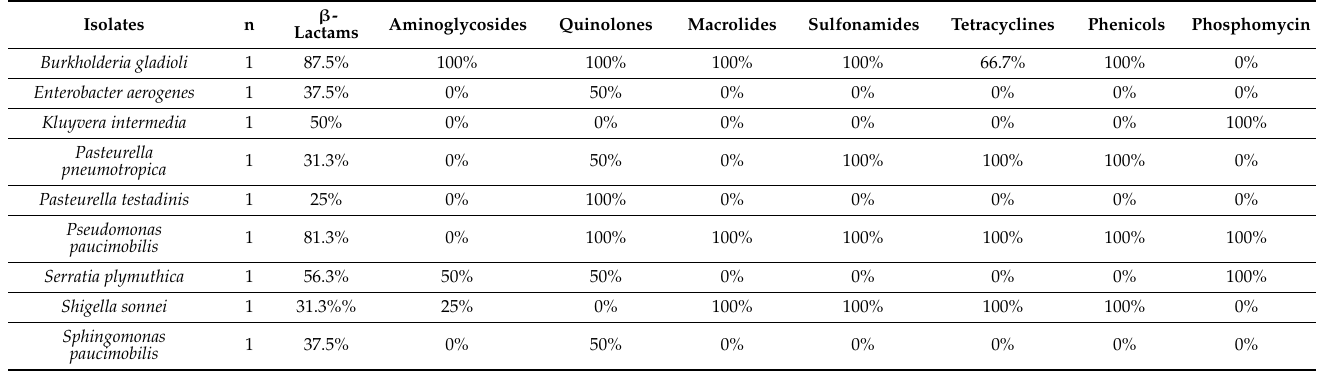
Table 2. Resistance to the antimicrobial classes tested. Only bacterial species with one isolate are